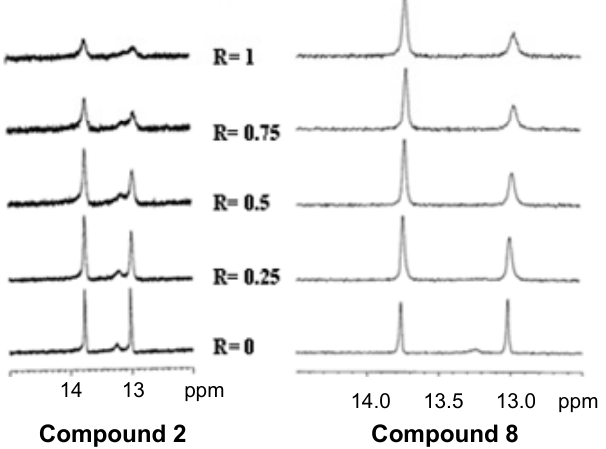
Figure 5. Imino proton region of (CGATCG) with compounds 2 and 8